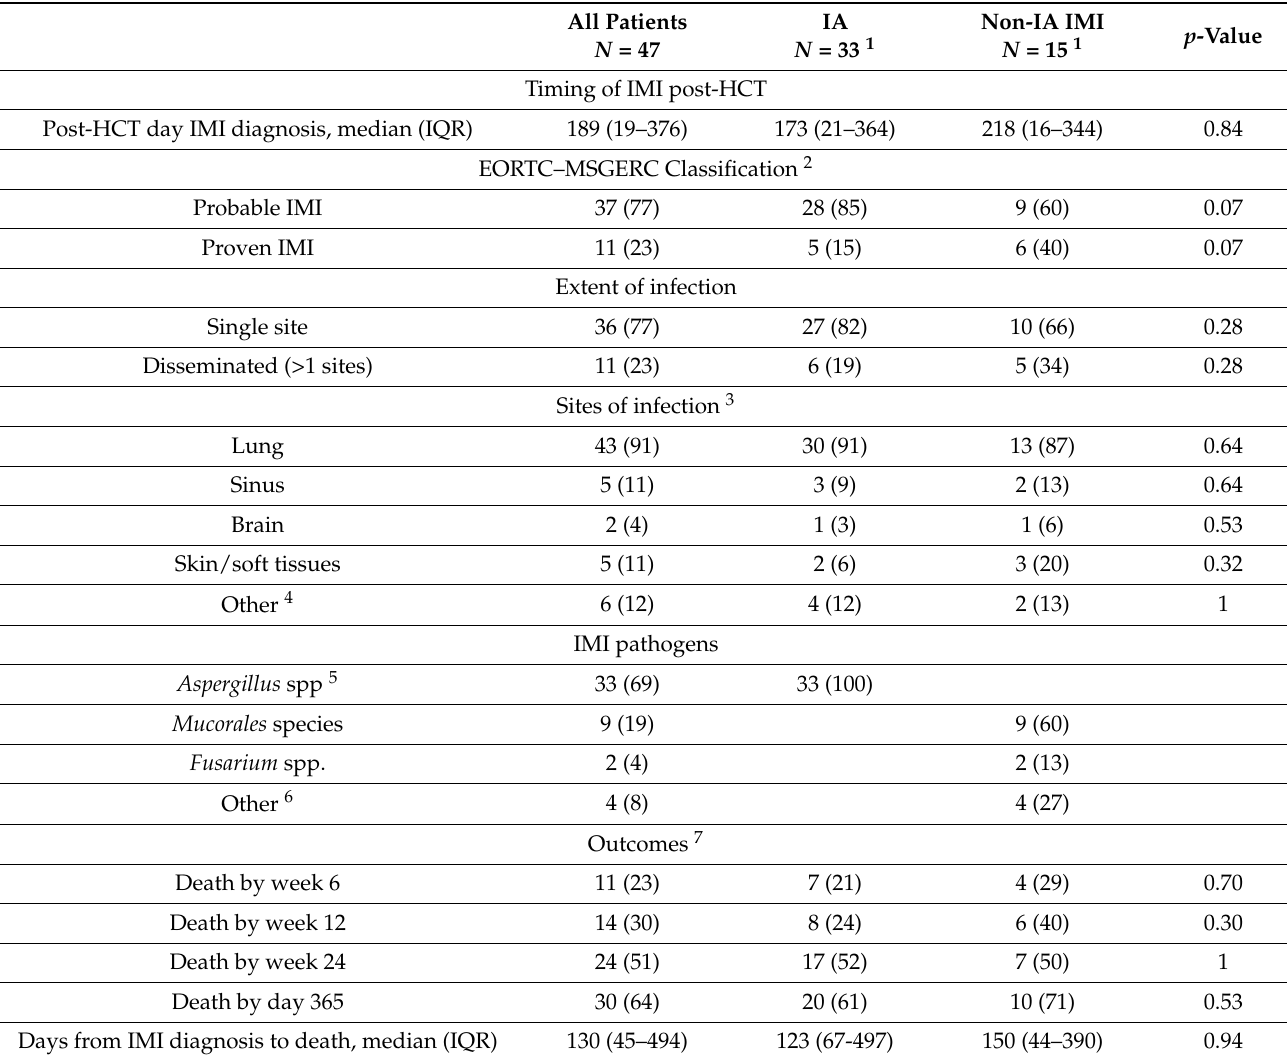
Table 2. Characteristics and outcomes of 48 invasive mold infections in 47 allogeneic hematopoietic cell transplant recipients.